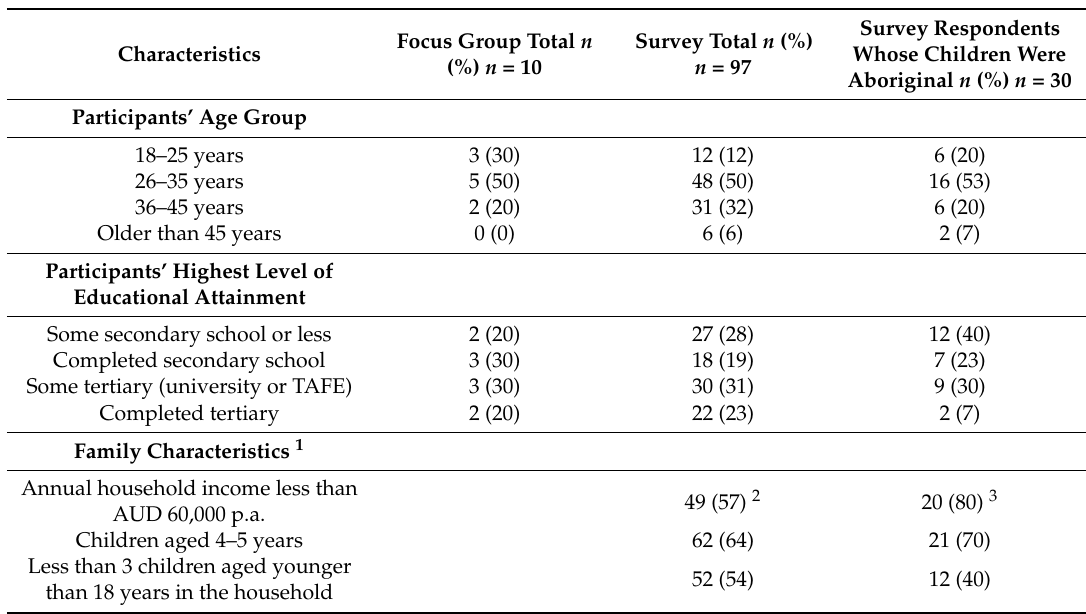
Table 1. Age, educational attainment and family characteristics of focus group ( n = 10) and survey participants ( n =